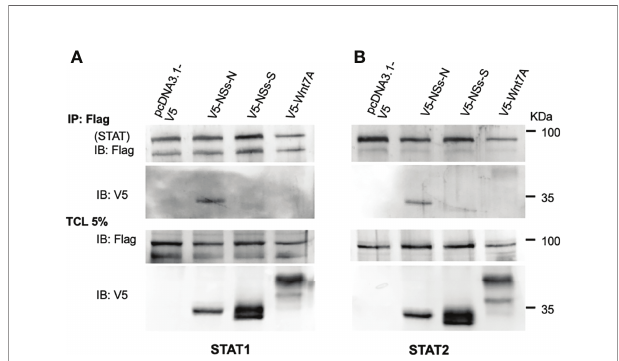
FIGURE 4 | NSs-N interacts with both STAT1 and STAT2, but NSs-S does not. (A) HEK293 cells were cotransfected with FLAG-tagged STAT1 or STAT 2 (B) expressing plasmids and V5-tagged sand fl y NSs expressing plasmids. An empty plasmid and a plasmid expressing an unrelated protein V5-Wnt7A were used as controls. Immunoprecipitation (IP) was performed 48 h post- transfection using FLAG beads. Total cell lysates (TCL) and IP products were analyzed by western blot using the indicated